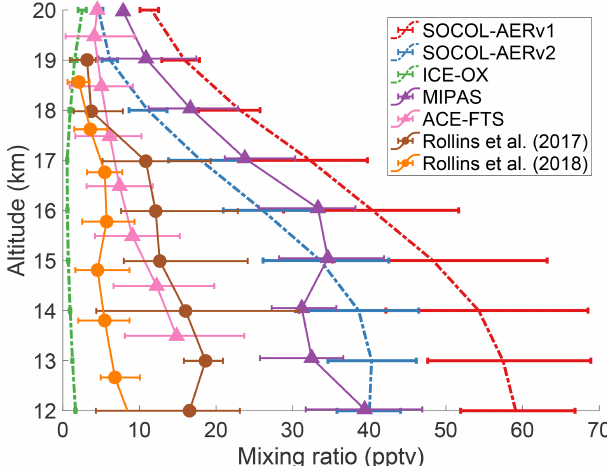
Figure 5. Comparing modeled and measured SO 2 mixing ratios in the tropical UTLS region between 10 and 25 ◦ N. Modeled re- sults from three simulations are averaged over 5 years of the time slice and are shown as colored dashed lines. Horizontal error bars indicate the interquartile range of monthly means. Observational datasets are shown as solid lines with interquartile ranges, extracted from data in Fig. 3 of Rollins et al. (2017) and Fig. 11 of Rollins et al. (2018). The satellite datasets (triangles), MIPAS and ACE- FTS, show mean SO 2 values between 2002–2012 and 2004–2010, respectively, and have been filtered to remove any data affected by major volcanic eruptions. Rollins et al. (2017) data (brown circles) represent in situ flight data from October 2015 over the Gulf of Mexico and the tropical eastern Pacific Ocean. Rollins et al. (2018) data (orange circles) were measured in a flight campaign over the tropical western Pacific Ocean in October 2016. Model and satellite data are averaged over all longitudes between 10 and 25 ◦